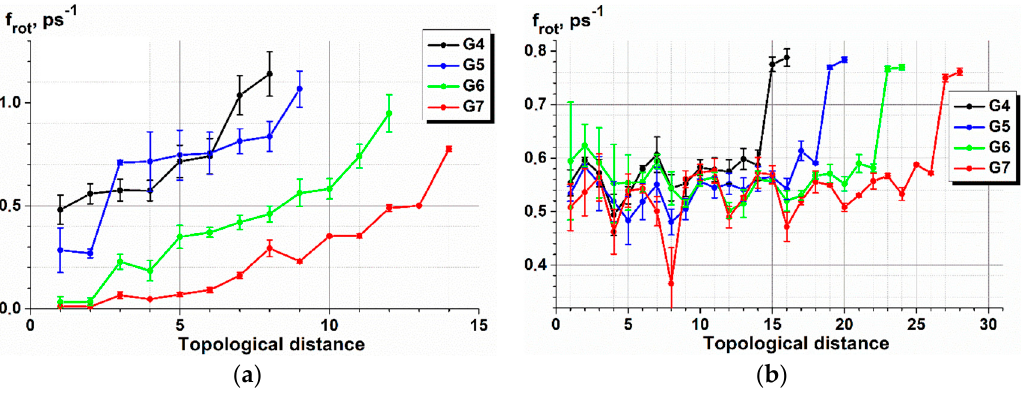
Figure 13. The average frequency of the transitions between the trans and gauche conformations vs. the number bonds (calculated from the core Si atom) for the s-dendrimers ( a ) and l-dendrimers ( b ) of various generation numbers.